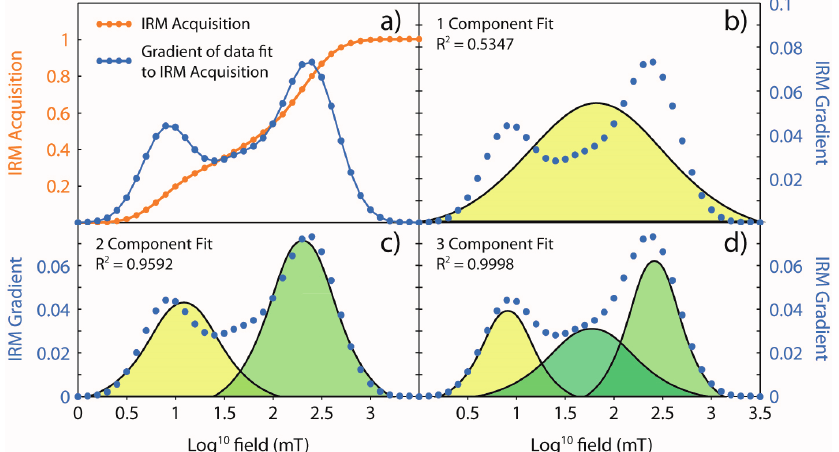
Figure 1. ( a ) Isothermal Remanent Magnetization (IRM) acquisition curve (orange dots and line) and the gradient of the IRM (blue dots). One ( b ), two ( c ), and three ( d ) cumulative log Gaussian (CLG) distribution fits are shown to the data with their associated R 2 values. Note the greater fit of three CLG distributions to the IRM gradient data suggesting that the bulk magnetic dataset is best described as having contributions from three coercivity distinct components. Redrawn from Heslop et al.